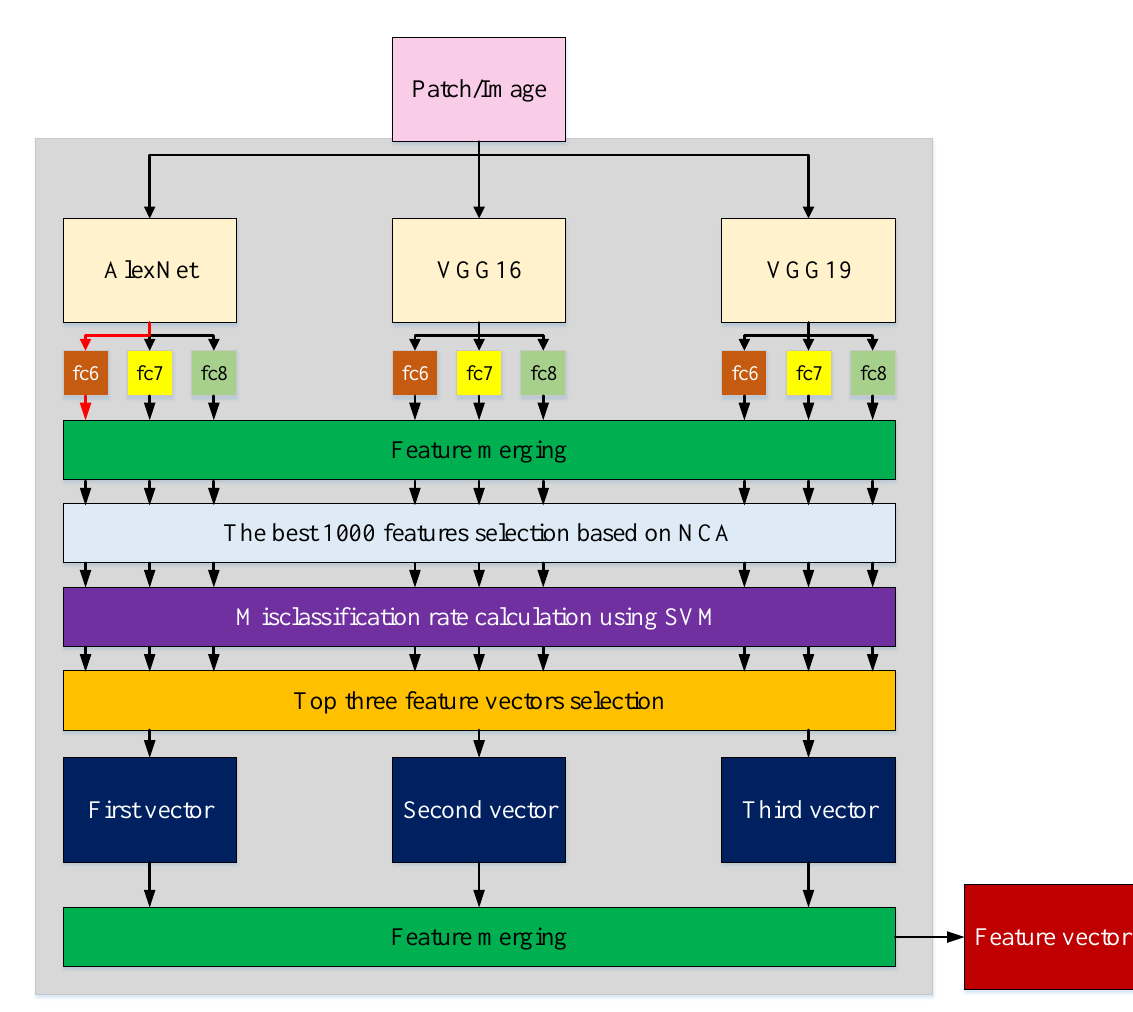
Figure 6. Detailed representation of proposed deep feature generator. The red arrow shows the activated feature extraction cell. All fully connected layers are activated consecutively in the presented hybrid deep feature generator.